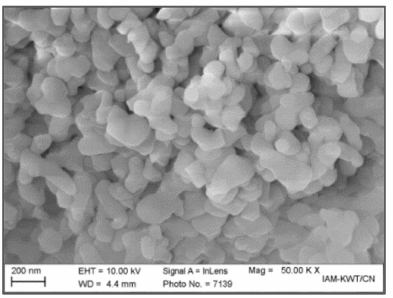
Figure 1. SEM-image of used nanosized alumina TM-DAR.